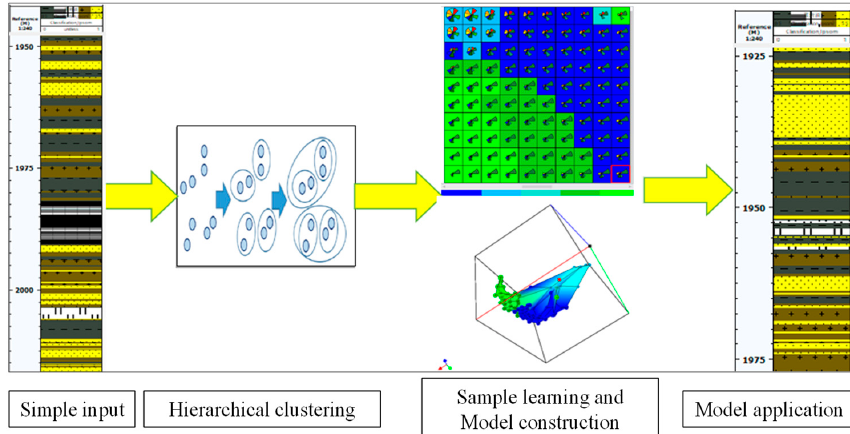
Figure 8. Flow chart of well logging lithology identi fi cation based on cluster analysis.